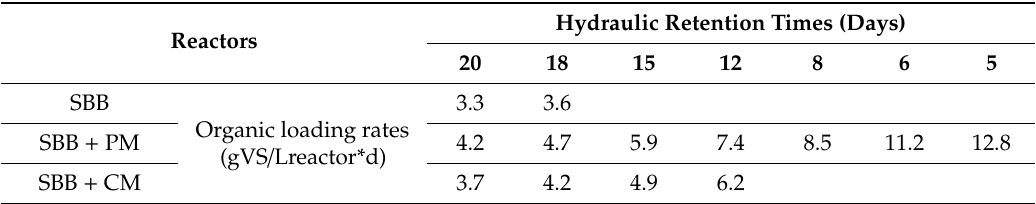
Table 2. The operation conditions (hydraulic retention times and organic loading rates) of the three semi-continuous stirred tank reactors (SSTR)